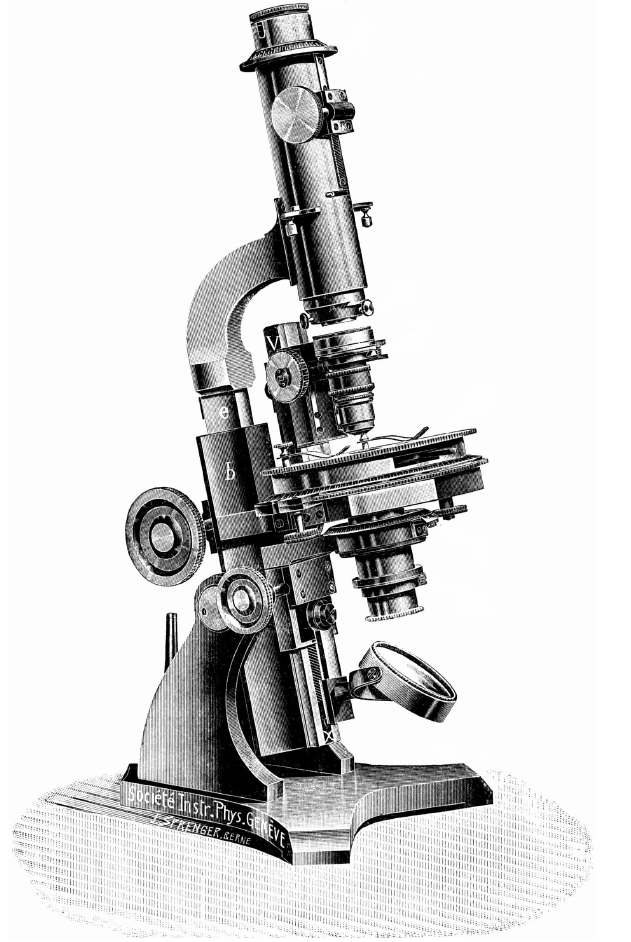
Figure 5. An advanced petrographic microscope, made around 1905. One Nicol prism is below the platform which holds thin- section specimens, and another one is at the top. From Duparc and Pearce